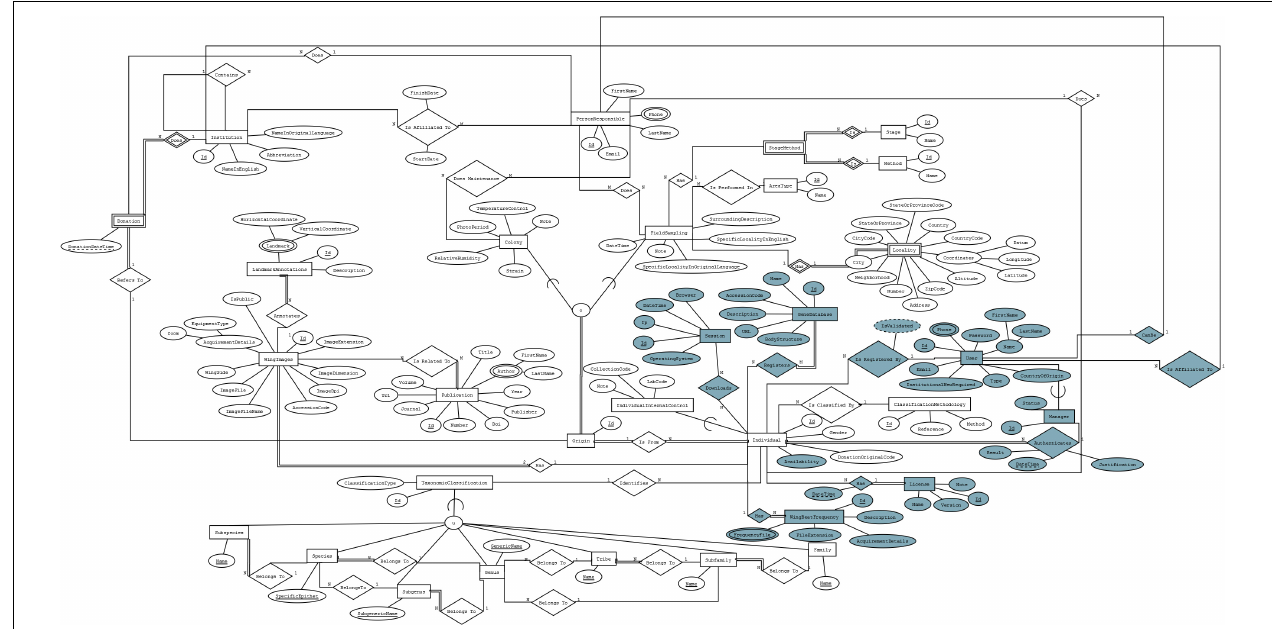
FIGURE 2 | Representation of the Conceptual Database Design through an Enhanced Entity-Relationship (EER) diagram. Rectangles: types of entities, which represent the abstraction of a real-world object. Ellipses: Attributes, which are details, properties that characterize a type of entity. Diamonds: types of relationships, which represent associations between entities, accompanied by their participation restrictions and cardinalities. Filled geometric forms: Entity, Attributes and Relationships which were planned but not yet implemented (Phase II).